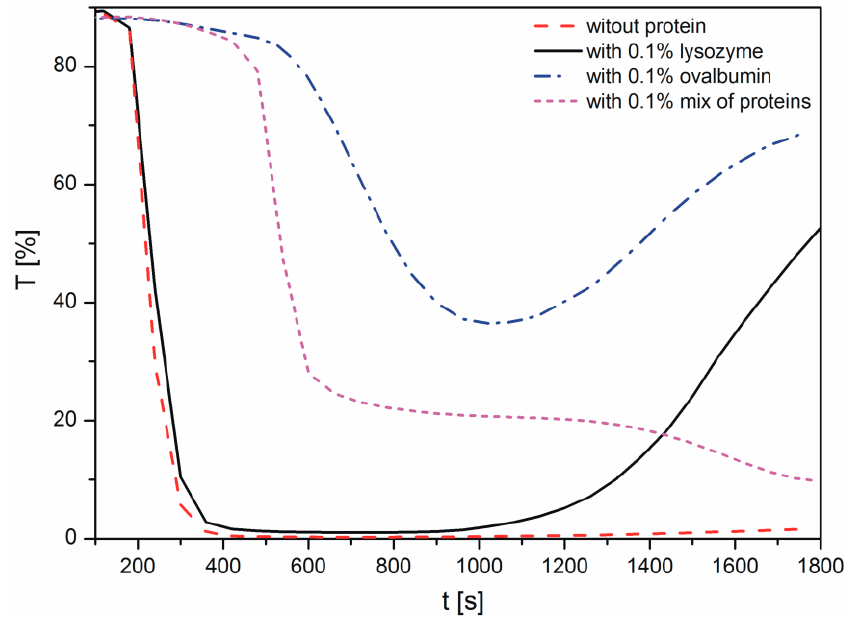
Figure 1. Transmission curves observed during precipitation of calcium carbonates.